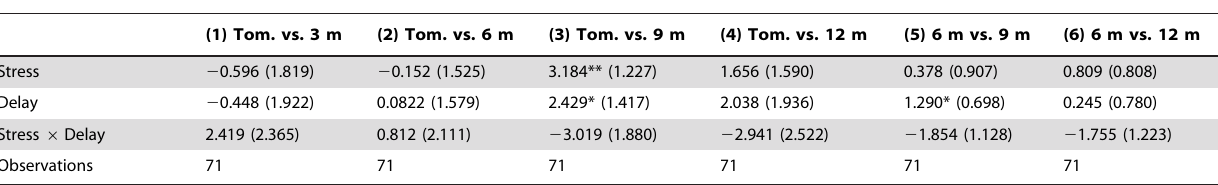
Table 6. Effect of stress manipulation on indifference points in intertemporal choice task for patient subjects